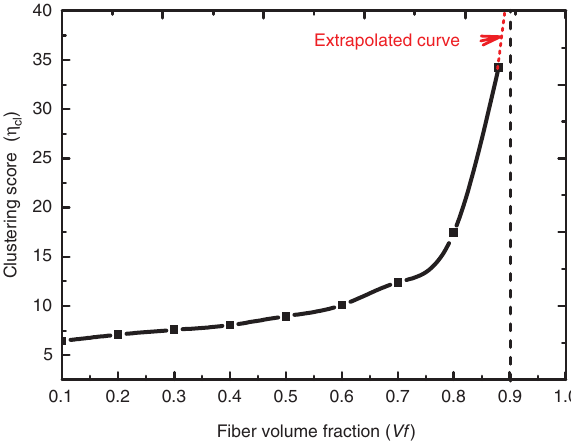
indicates the linear increase of clustering strength for the initial volume fractions (0.1 ~ 0.7). A sudden rise in the clustering score is observed as volume fraction goes beyond 0.7. It asymptotes to ∞ for the peak fiber volume = 0.9072). fraction ( vf h